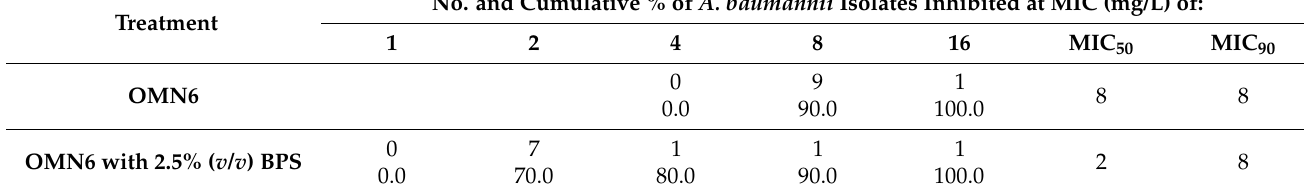
Table 2. Modal MIC values of OMN6 against 10 A. baumannii clinical isolates with or without addition of 2.5% ( v / v ) Bovine Pulmonary Surfactant (BPS). Bacteria were subjected to MIC tests by broth microdilution method following the principles outlined in Clinical and Laboratory Standards Institute (CLSI) guidelines. The mode of ≥ 3 MIC values for each strain/testing condition combination is shown. Supplementary information about the resistance pattern of the bacterial strains used in this study is displayed in Table